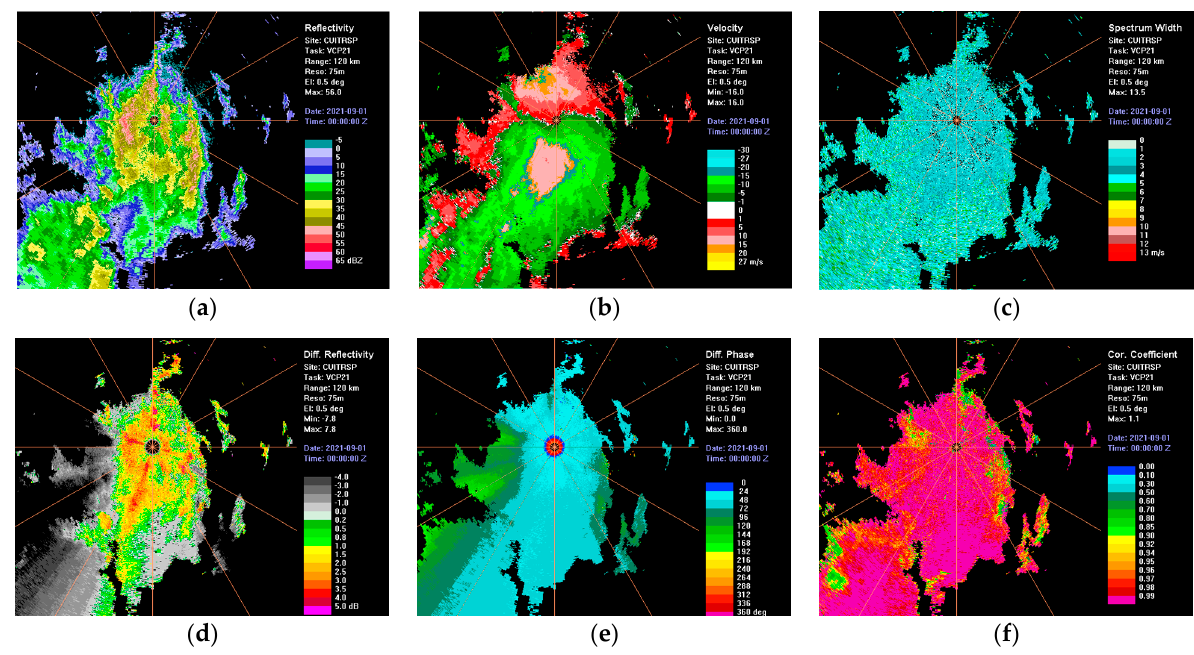
Figure 5. The PPI display of reference scene base data. ( a ) Reflectivity; ( b ) radial velocity; ( c ) spectrum width; ( d ) differential reflectivity; ( e ) differential phase; ( f ) correlation coefficient.